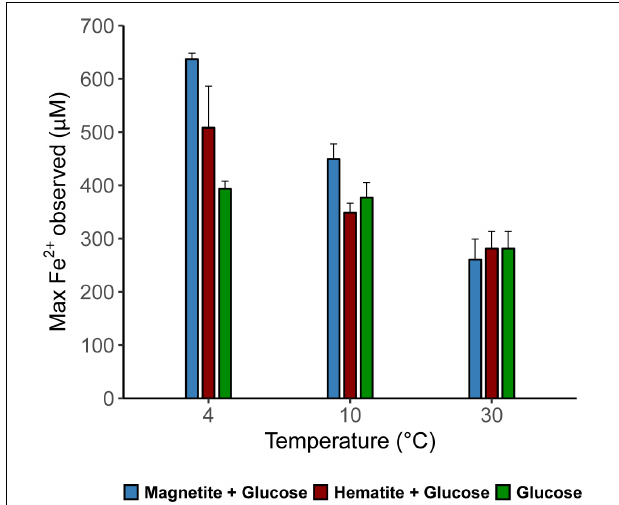
FIGURE 2 | Maximum dissolved Fe ( µ M) measured in the various treatments across all temperatures showing the effect of crystalline iron minerals on iron reduction in sediment incubations.